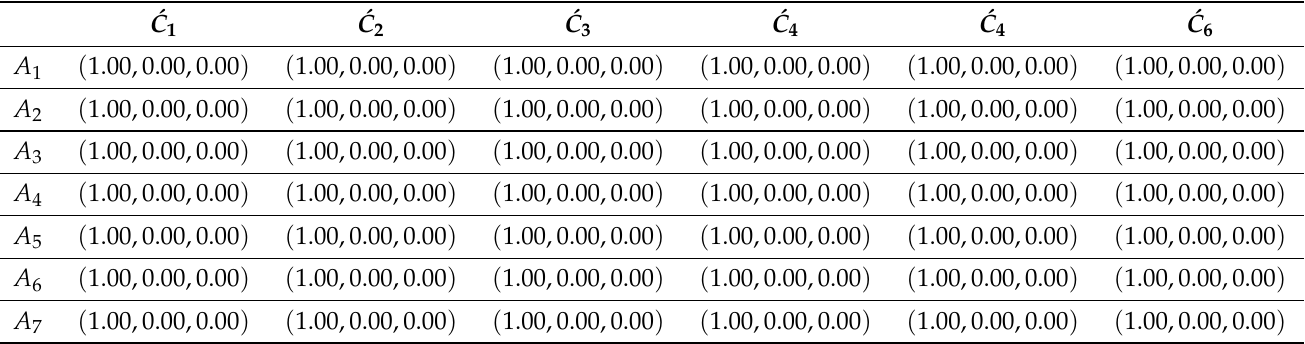
Table 15. Decision matrix D 4